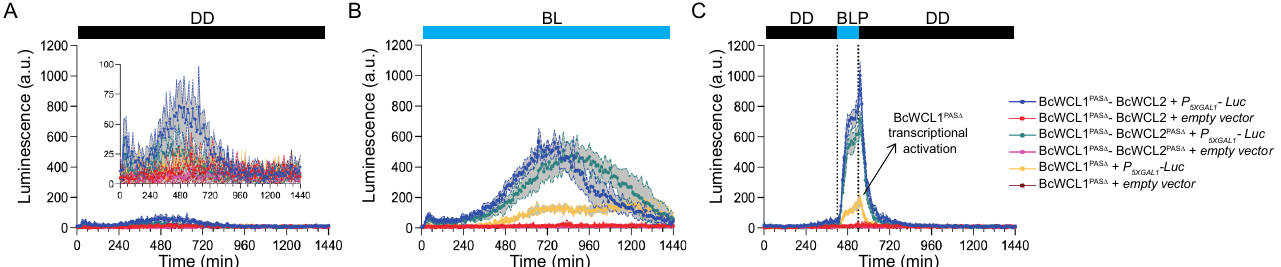
Figure 4. The protein interactions between BcWCL1 PAS ∆ and BcWCL2 or BcWCL2 PAS ∆ respond to blue-light stimulation. The BcWCL1 protein carrying a deletion in the PAS domains (BcWCL1 PAS ∆ ) was assayed for protein–protein interaction with the full length BcWCL2 or its variant without PAS domain (BcWCL2 PAS ∆ ), respectively. The individual contribution of BcWCL1 PAS ∆ in the light-mediated transcriptional activation was included as control. Luciferase expression was measured as luminescence in arbitrary units (a.u.) of the yeast cell cultures. The protein–protein interaction activates luciferase expression controlled by the 5XGAL1 synthetic promoter ( P 5XGAL1 ) under three different conditions: ( A ) constant darkness (DD), ( B ) constant blue light (BL), and ( C ) a single blue-light pulse of 2 h duration (between dotted lines). In all panels, the average of six biological replicates is shown, with standard deviation represented as shadowed regions.